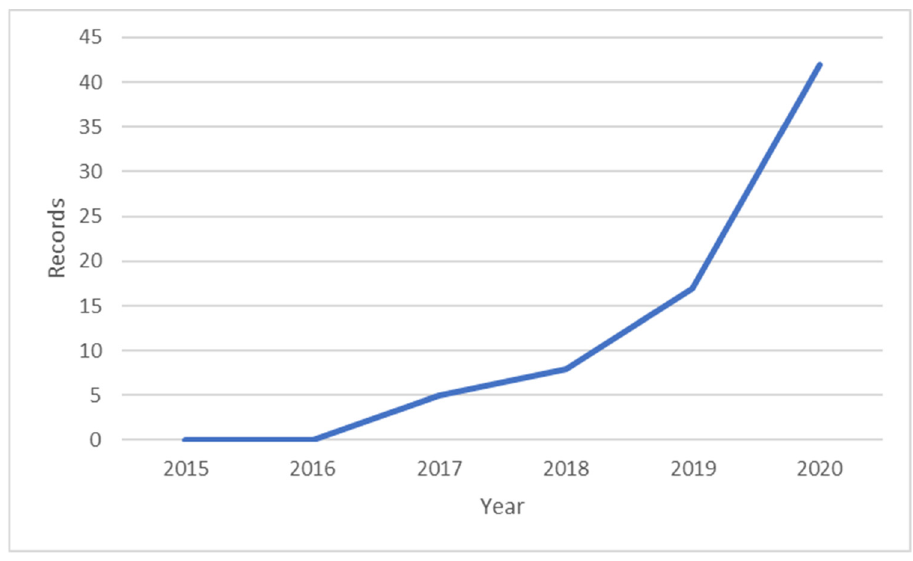
Figure 2. Identified records by year of publication.